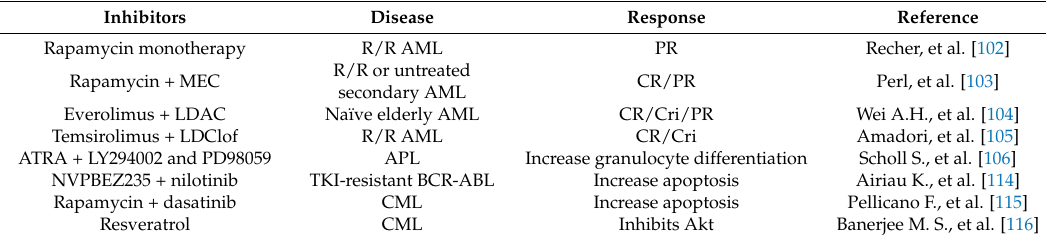
Table 1. mTOR inhibitors in myeloid leukemias.